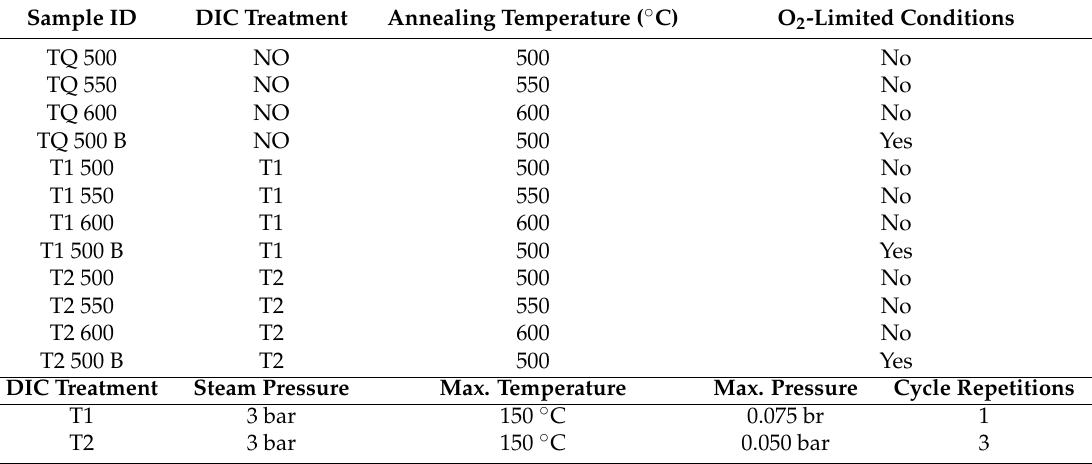
Table 1. Samples description and treatments. All the thermal annealing were made for 270